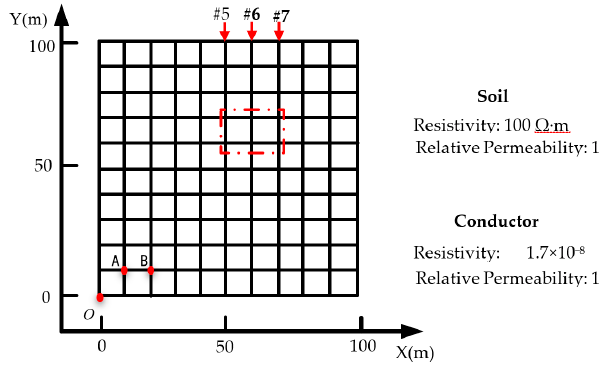
Figure 5. Grounding grid and survey area.